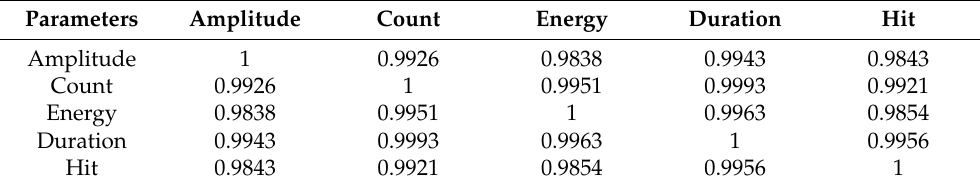
Table 2. Interrelationship values between different acoustic emission accumulation parameters. Parameters